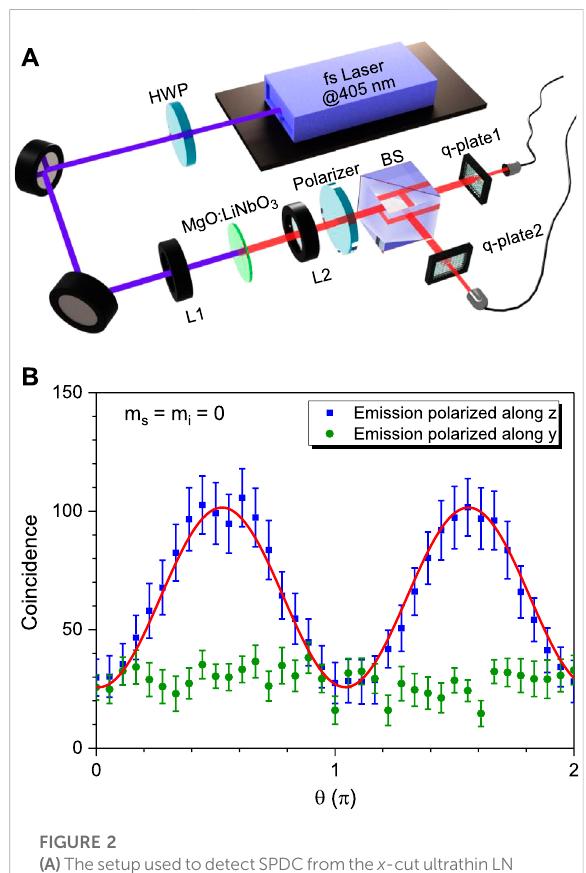
FIGURE 2 (A) ThesetupusedtodetectSPDCfromthe x -cutultrathinLN fi lm. The pump power is 250 mw. HWP: halfwave plate, BS: beam splitter, L1 and L2: lens (B) The coincidence rate of the fundamental mode ( m = 0) versus the pump polarization direction, for the emission polarized along z (blue squares, red fi t) and along y (green triangles). θ is the angle between the pump polarization and the y axis. The coincidence time is 1 s